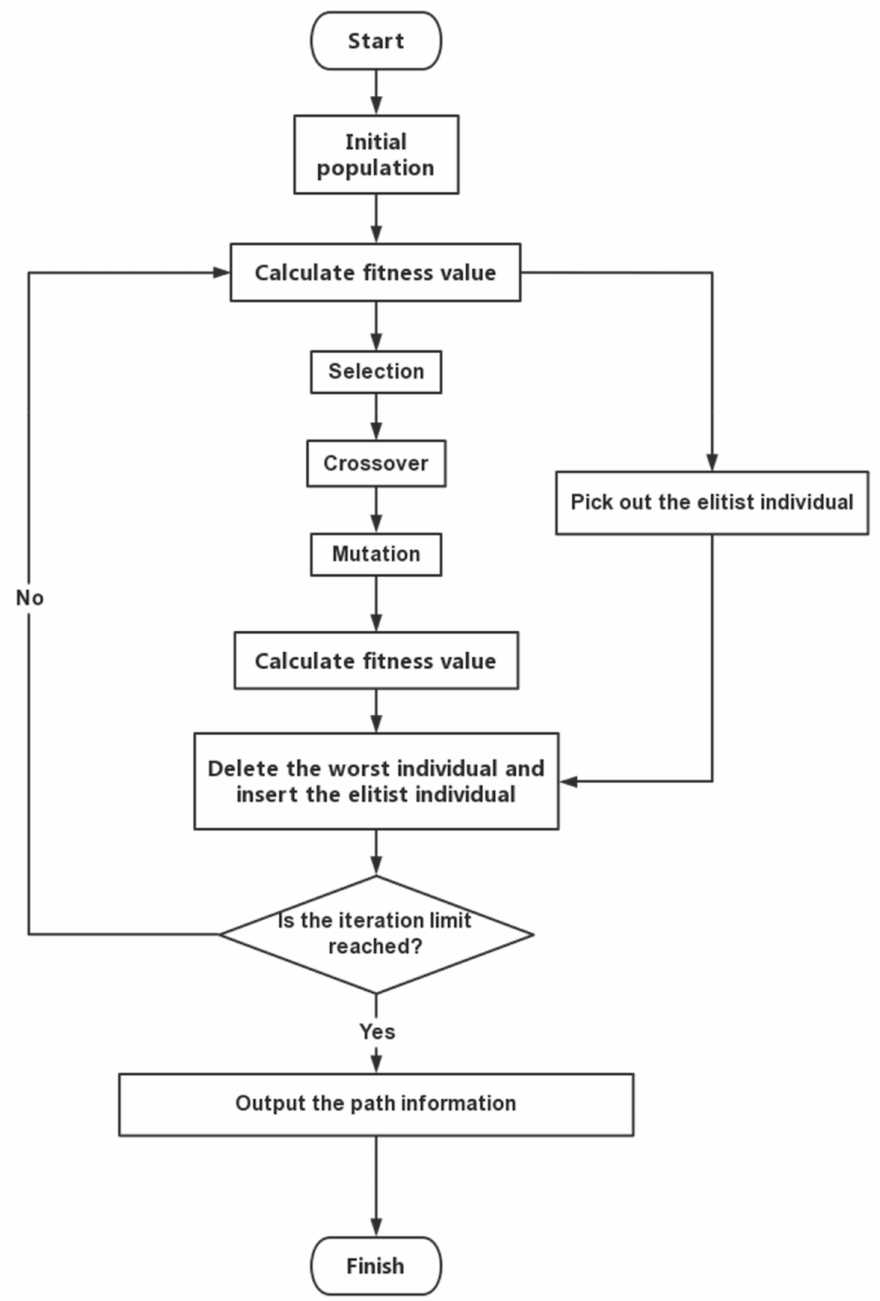
Figure 7. Flowchart of